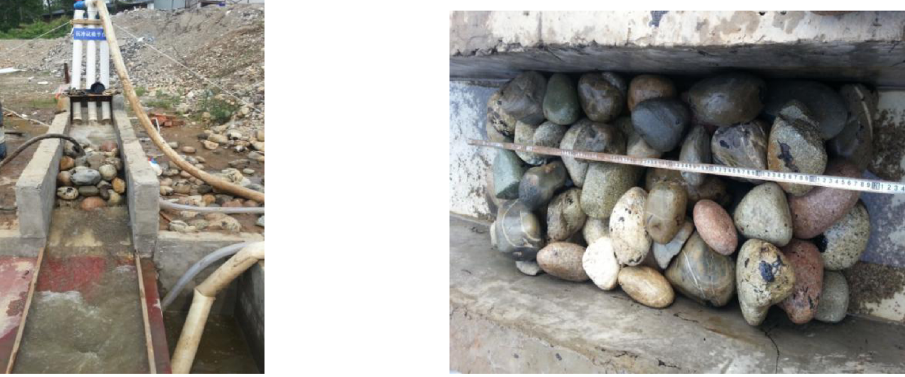
Figure 12: Image of the impact experimental model.